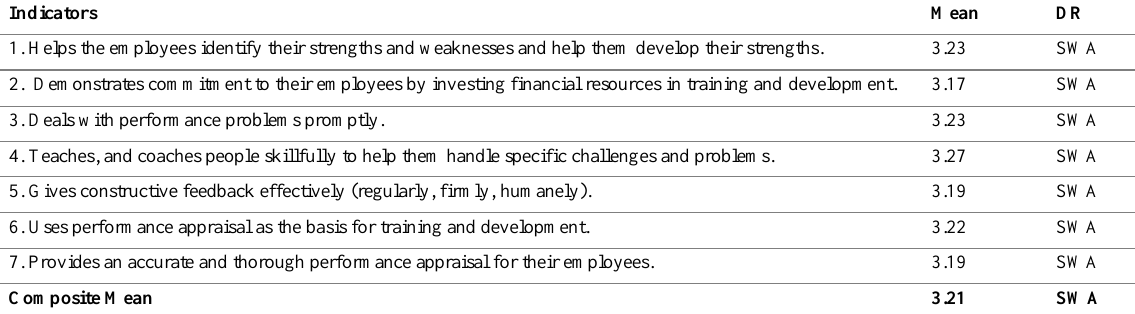
Table 4: The Leadership Skills of Administrators of Divine Word Colleges in the Ilocos Region in terms of Developing People